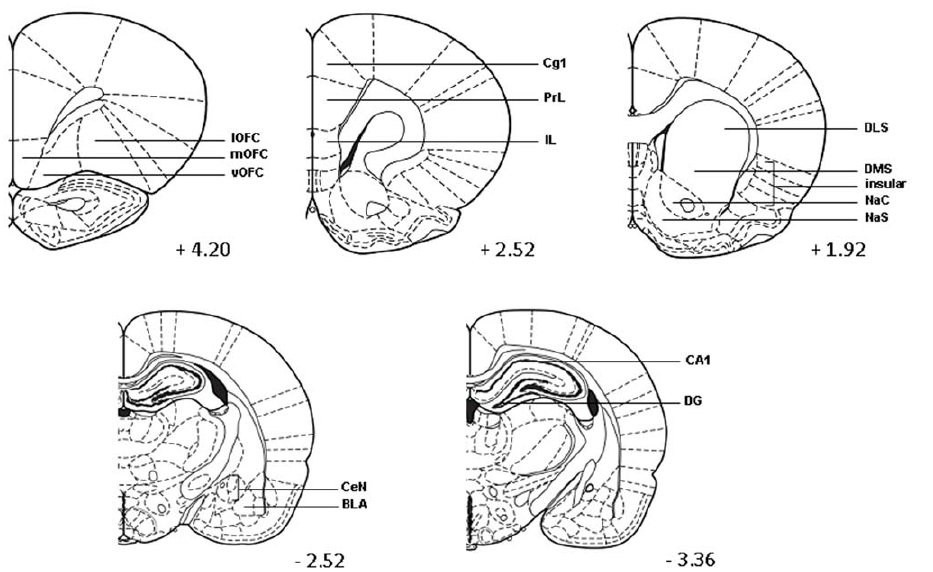
Figure 3. Anatomical localization of brain regions used for analysis of c-fos expression. Anterior-posterior coordinates relative to bregma are stated below each coronal section. Abbreviations: mOFC=medial orbital frontal cortex (OFC)), vOFC=ventral OFC, lOFC=lateral OFC, insular=insular cortex, Cg1=cingulate cortex, PrL=prelimbic cortex, IL=infralimbic cortex, DLS=dorsolateral striatum, DMS=dorsomedial striatum, NaC=nucleus accumbens core, NaS=nucleus accumbens shell, BLA=basolateral amygdala, CeN=central nucleus of the amygdala, DG=dentate gyrus and CA1=CA1 regio of the hippocampus. Based on Paxinos and Watson (2005).